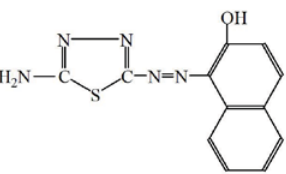
Figure 2. Chemical structure of